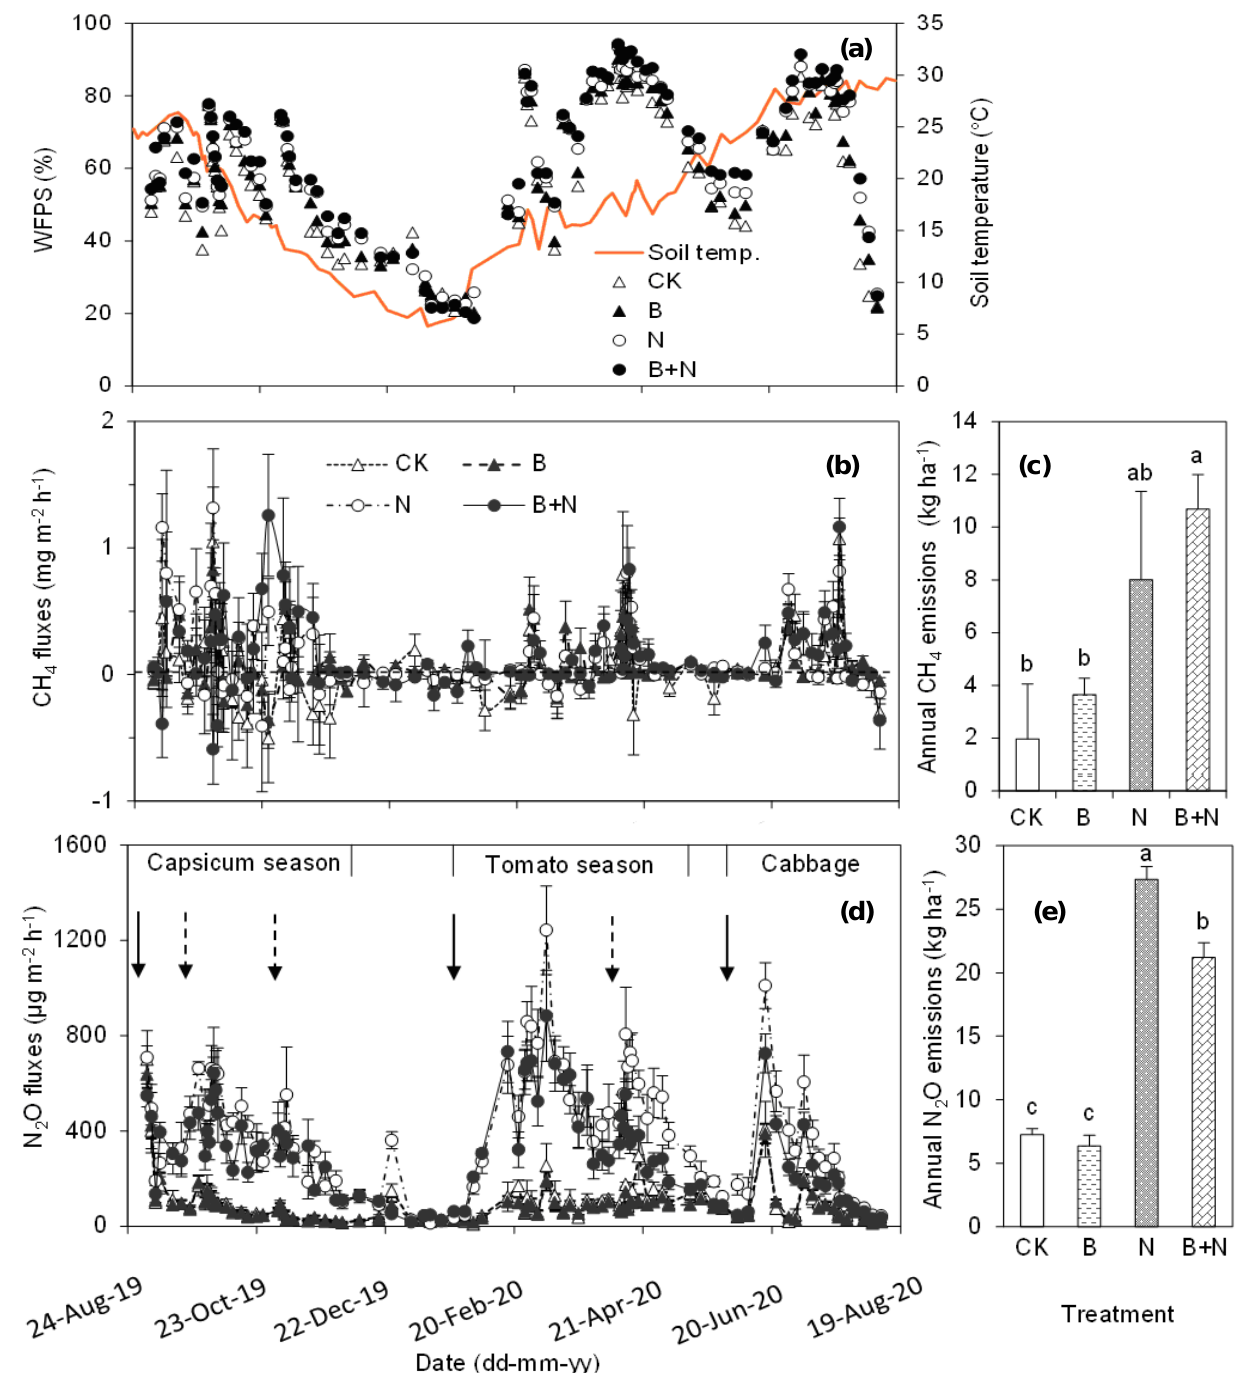
Figure 1. Seasonal dynamics of soil temperature and WFPS ( a ), CH 4 fluxes ( b ), Annual CH 4 emmisions( c ), N 2 O fluxes( d ) and Annual N 2 O emissions( e ) across treatments from the greenhouse vegetable cropping system over the 2019-2020 an- nual cycle. CK represents the Control, no N fertilizer and biochar application; B, biochar alone; N, N fertilizer alone; B+N, N fertilizer and biochar amendment. Solid and dotted arrows indicate basal and topdressing events, respectively.